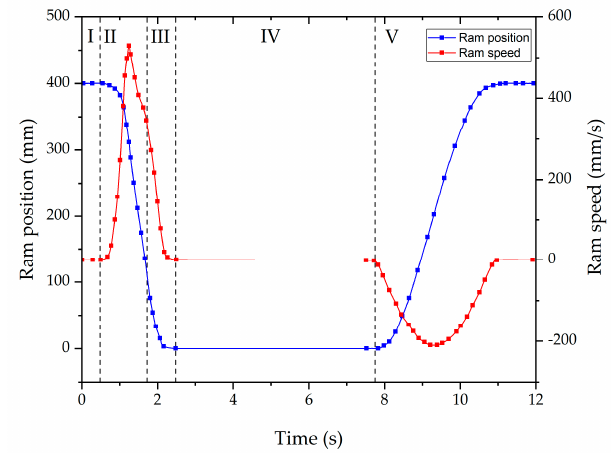
Figure 4. Schematic representation of the default press position and speed during NSF process: I —press waits for the billet placement, II —punch approaching the billet, III —Deformation stage, IV —5 s of dwelling at bottom dead center (BDC) and V —ram movement back to top dead center (TDC).